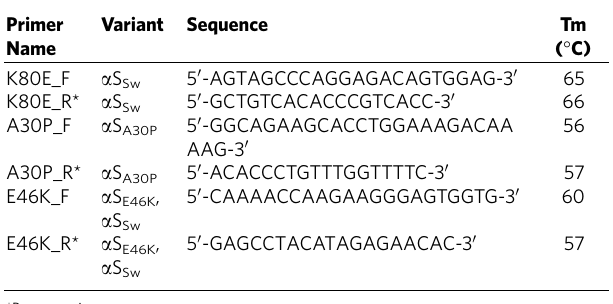
Table 1 | Primers used in this